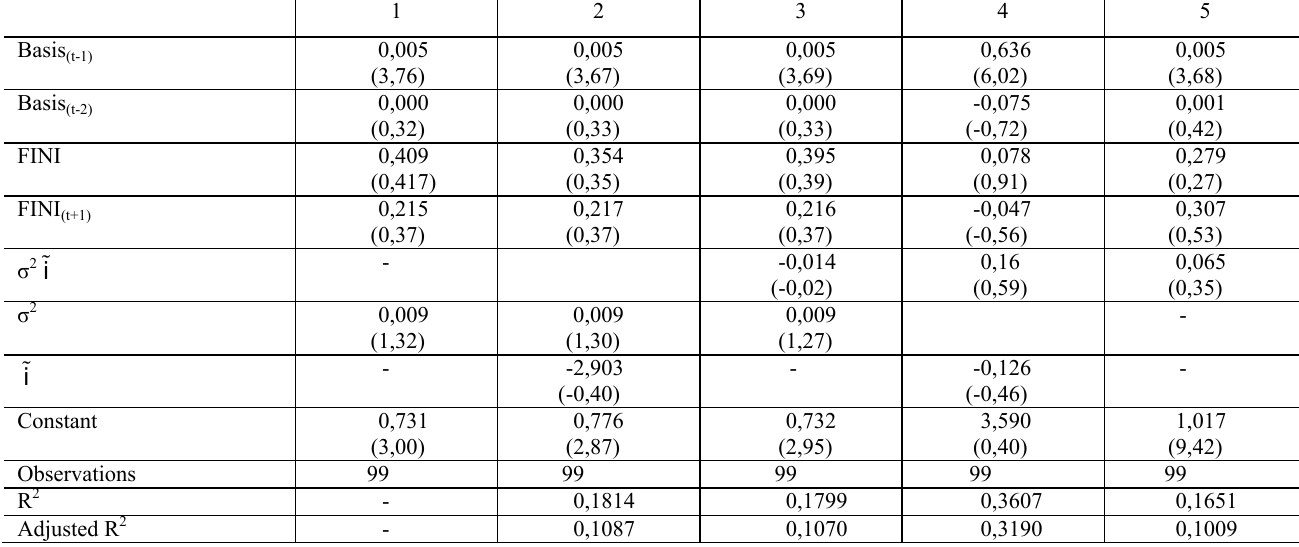
Table 4: Daily regressions of implied volatility on basis –